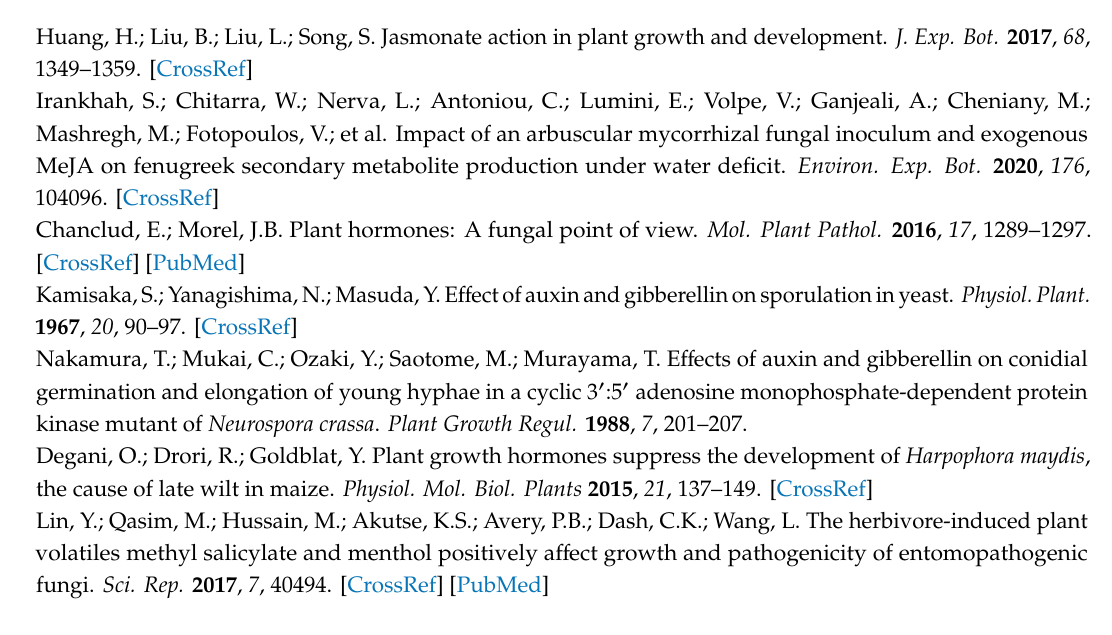
s1, Figure S1: E ff ect of compounds on the growth of esca disease-linked species. Culture medium was amended with molecules at 50 µ M concentration; values are reported as inhibition percentage as compared to the control (DMSO 0.5% v / v amended cultures) ± S.D. Di ff erent letters indicate statistically significant di ff erences ( p <